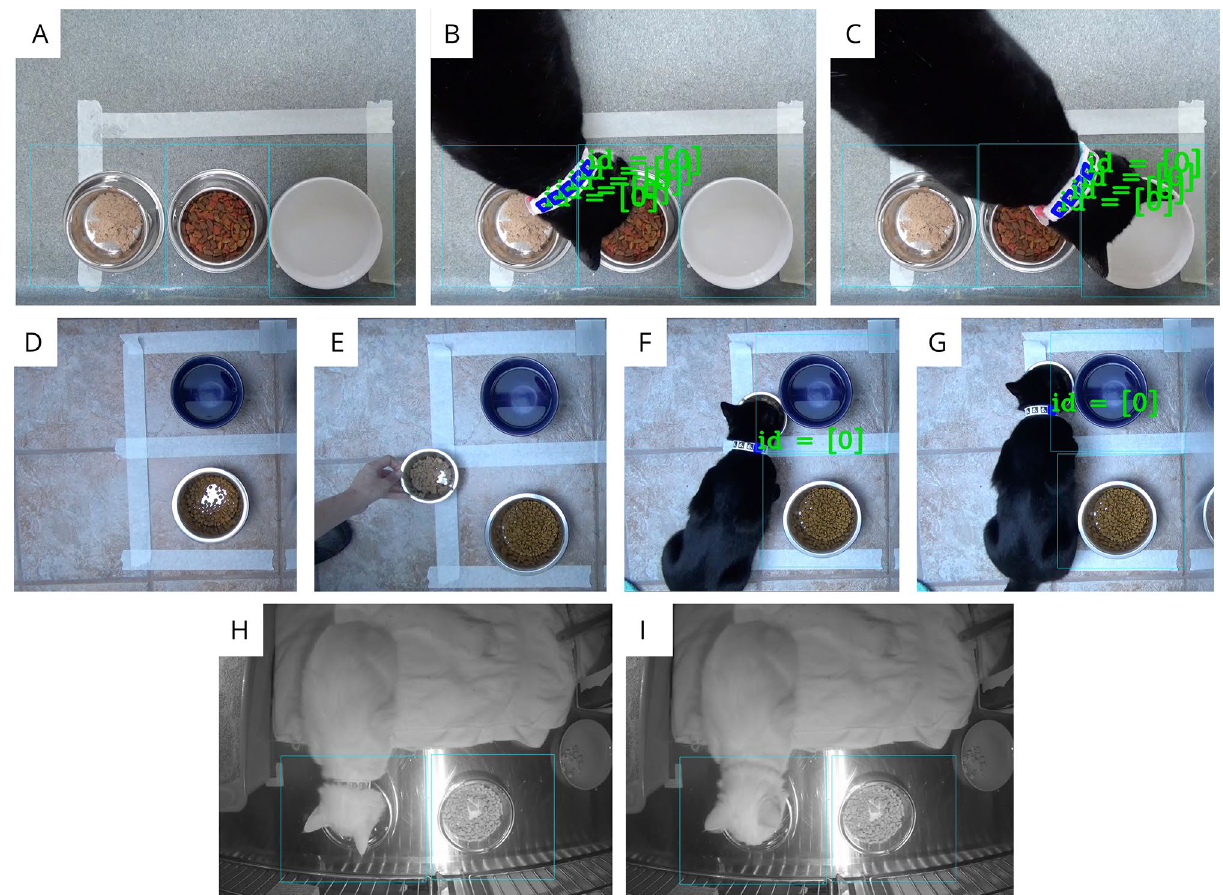
Figure 1. ( A ) Example of resources placed too close to one another. ( B ) Example of a detection occurring in region of interest (ROI) 0 [wet food] simultaneously while the cat is eating and being detected in ROI 1 [dry food] due to too close resource placement. ( C ) Example of a detection occurring in ROI 1 [dry food] simultaneously while the cat is drinking and being detected in ROI 2 [water] due to too close resource placement. ( D ) Example of resource placement including two ROIs (ROI 0 [water] ROI 1 [dry food]) with adequate spacing to ensure ROIs are not too close. ( E ) Example of an issue of an additional unintended resource being added within the ROI of ROI 0 [water] ROI 1 [dry food]. ( F ) Example of the use of an additional resource of wet food added to ROI region of (ROI 0 [water] ROI 1 [dry food]); therefore, detection represented in the green text occurred within the ROI of the unused resource. ( G ) Movement of the additional resource by a cat due to lightweight metal bowl as the cat moved the unintended additional resource across the ROIs. ( H ) An example of a cat using a resource in ROI 0 [water] and due to fur coverage, a detection was missed. ( I ) An example of a cat occupying a space within an ROI but not using the resource, resulting in no